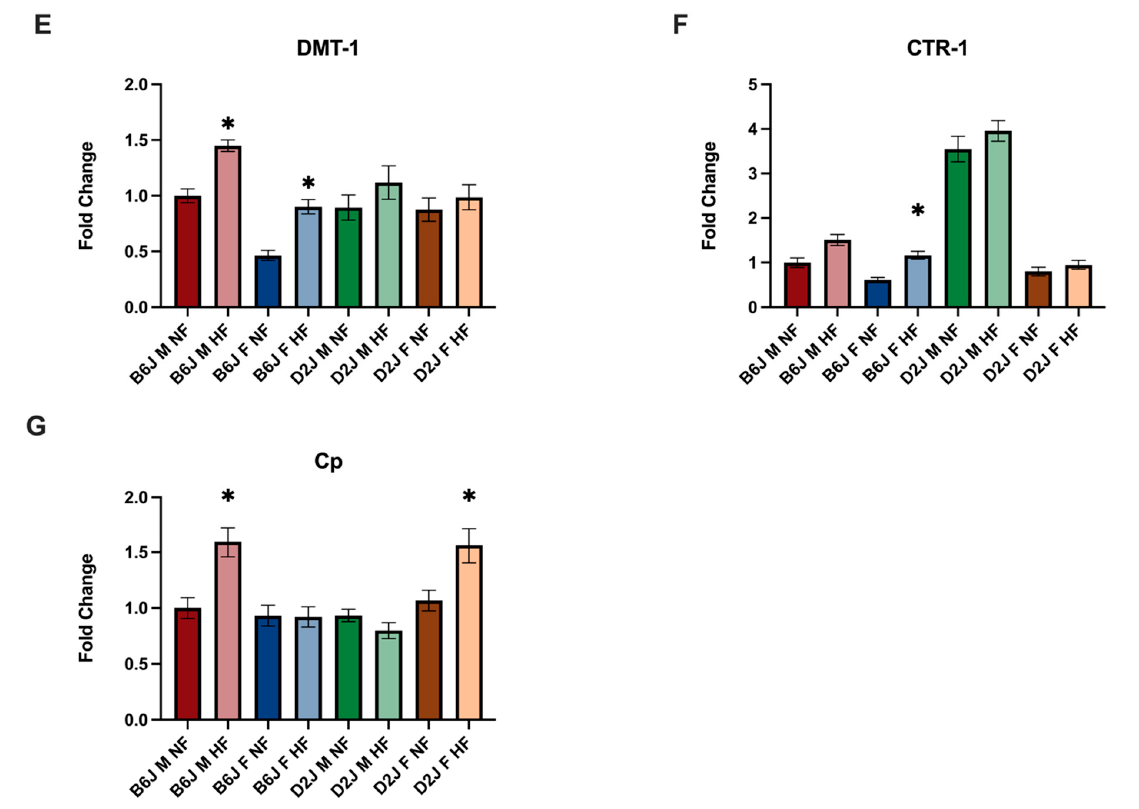
Figure 3. The effect of diet, sex, and strain on gene expression of proteins involved in trace element homeostasis in the liver. Gene expression is expressed as fold change normalized to the B6J male normal-fat groups are shown for ( A ) hypoxia inducible factor- α , ( B ) hepcidin, ( D ) iron regulatory protein-1, ( E ) divalent metal trasporter-1, ( F ) high affinity copper uptake protein-1, and ( G ) cerulo- plasmin. Significant effect of high fat diet compared to normal fat group is denoted. Gene expression is expressed as fold change normalized to B6J males is shown for ( C ) ferroportin for which significant effect of sex and strain is denoted. Data are represented as mean ± SEM, * p < 0.05. B6J M NF = B6J male normal fat, B6J M HF = B6J male high fat, B6J F NF = B6J female normal fat, B6J F HF =